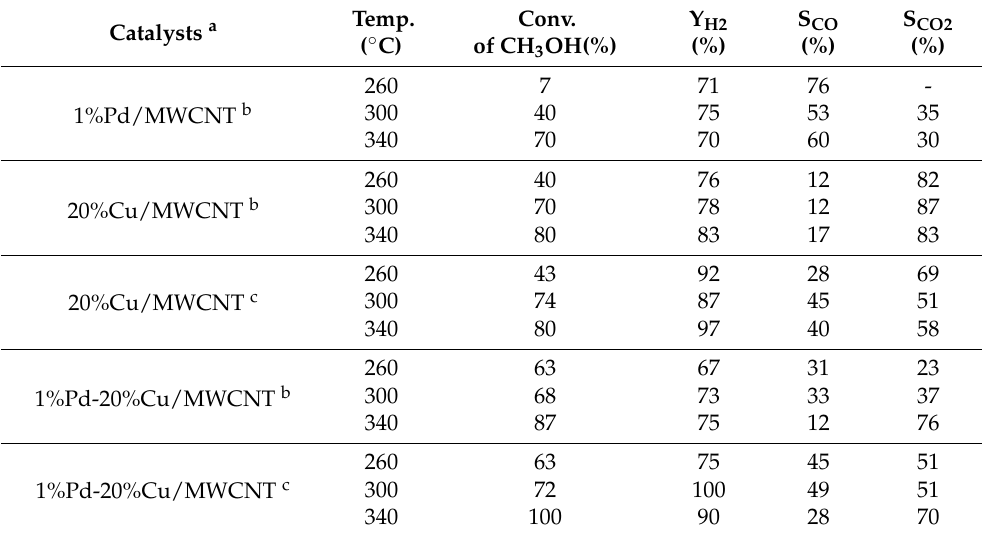
Table 2. The catalytic activity results obtained for the monometallic copper and the bimetallic Pd-Cu/MWCNTs catalysts evaluated during the steam reforming of methanol. Temp. Conv. Y H2 Catalysts a ( ◦ C) of CH 3 OH(%)